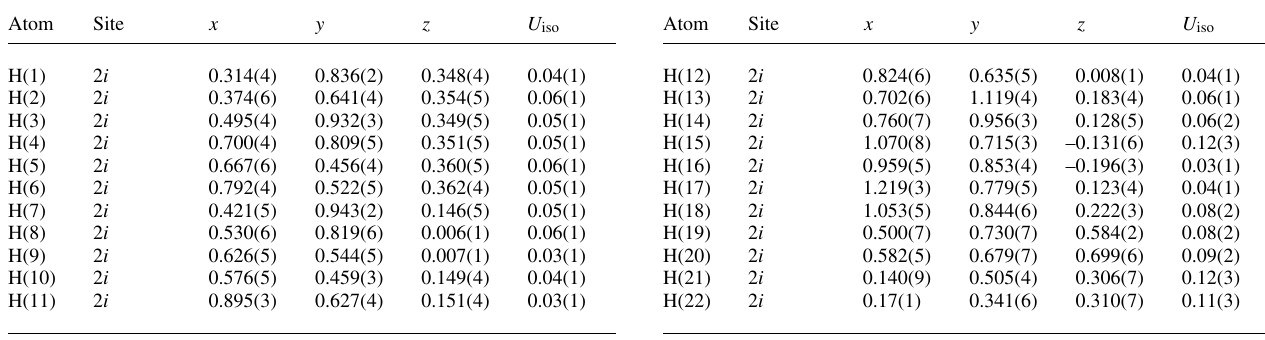
Table 2. Atomic coordinates and displacement parameters (in Å 2 )